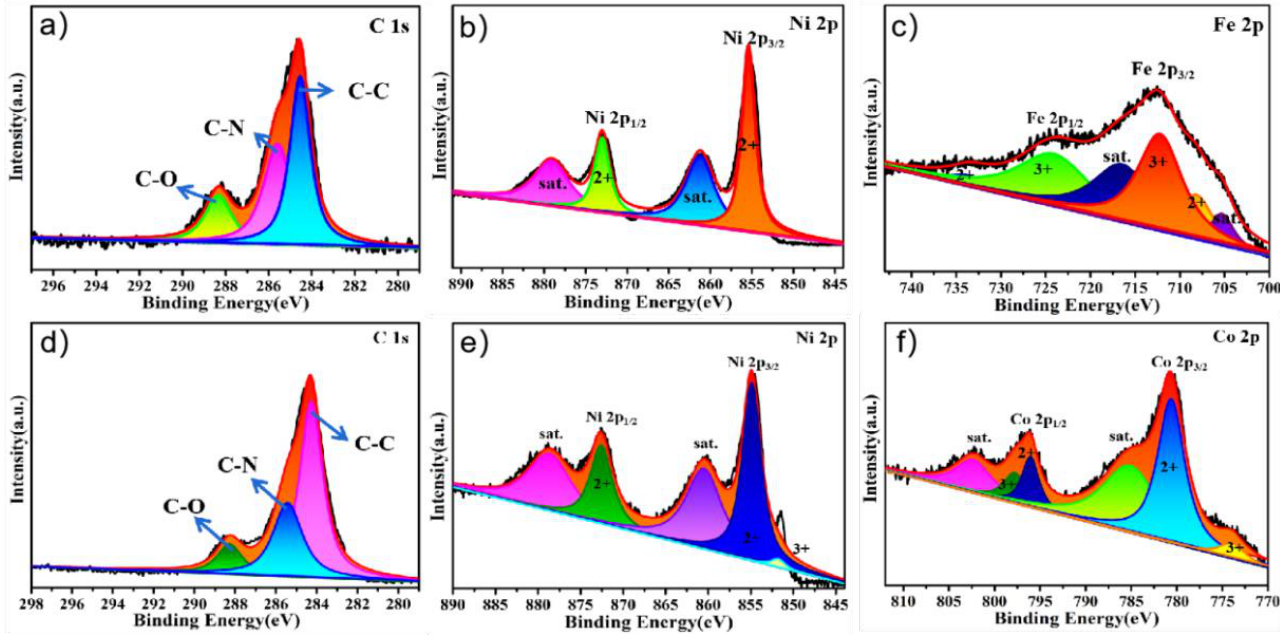
Figure 3. XPS survey scan of the PPy@FeNi 2 S 4 @NF: high − resolution XPS spectra of ( a ) C 1s, ( b ) Ni 2p and ( c ) Fe 2p. XPS survey scan of the PPy@NiCo 2 S 4 @NF: high − resolution XPS spectra of ( d ) C 1s, ( e ) Ni 2p and ( f ) Co